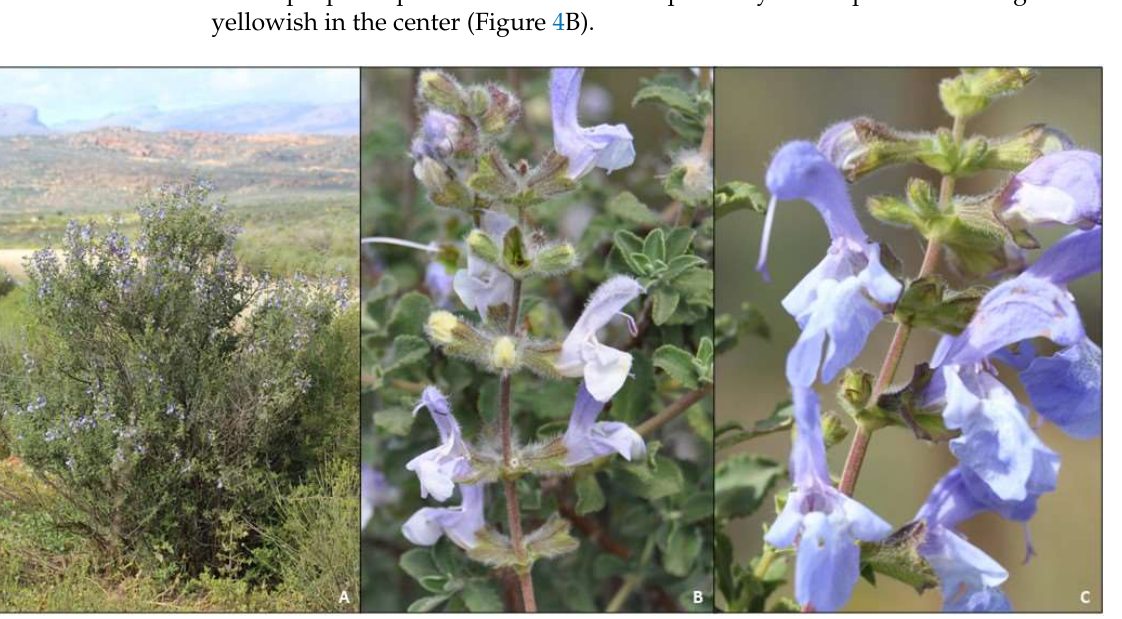
Figure 5. Morphology and diagnostic characters of Salvia chamelaeagnea . ( A ) habit (Piketberg); ( B ) inflorescence and leaves (Piketberg); ( C ) leaves and flowers (Darling); ( D ) flower (note glandular calyx). All photographs taken by B.-E. Van Wyk. 2.2. Ethnobotanical Data For the three Salvia species, the overall use categories with the highest number of use- records are respiratory system (32 records), gastrointestinal (16 records), analgesic (9 rec- ords), reproductive system (8 records) and topical applications (7 records; Figure 6). The ethnobotanical data show that Salvia dentata is mainly used for the treatment of respiratory ailments (colds, coughs and influenza), topical application, gastrointestinal (stomach com- plaints and diarrhoea) and unspecified medicinal uses (Table 1). Interestingly all three of